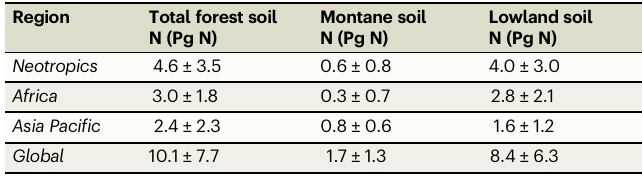
Table 1 | Total mineral soil N pool for global tropical forests Region Total forest soil N (Pg